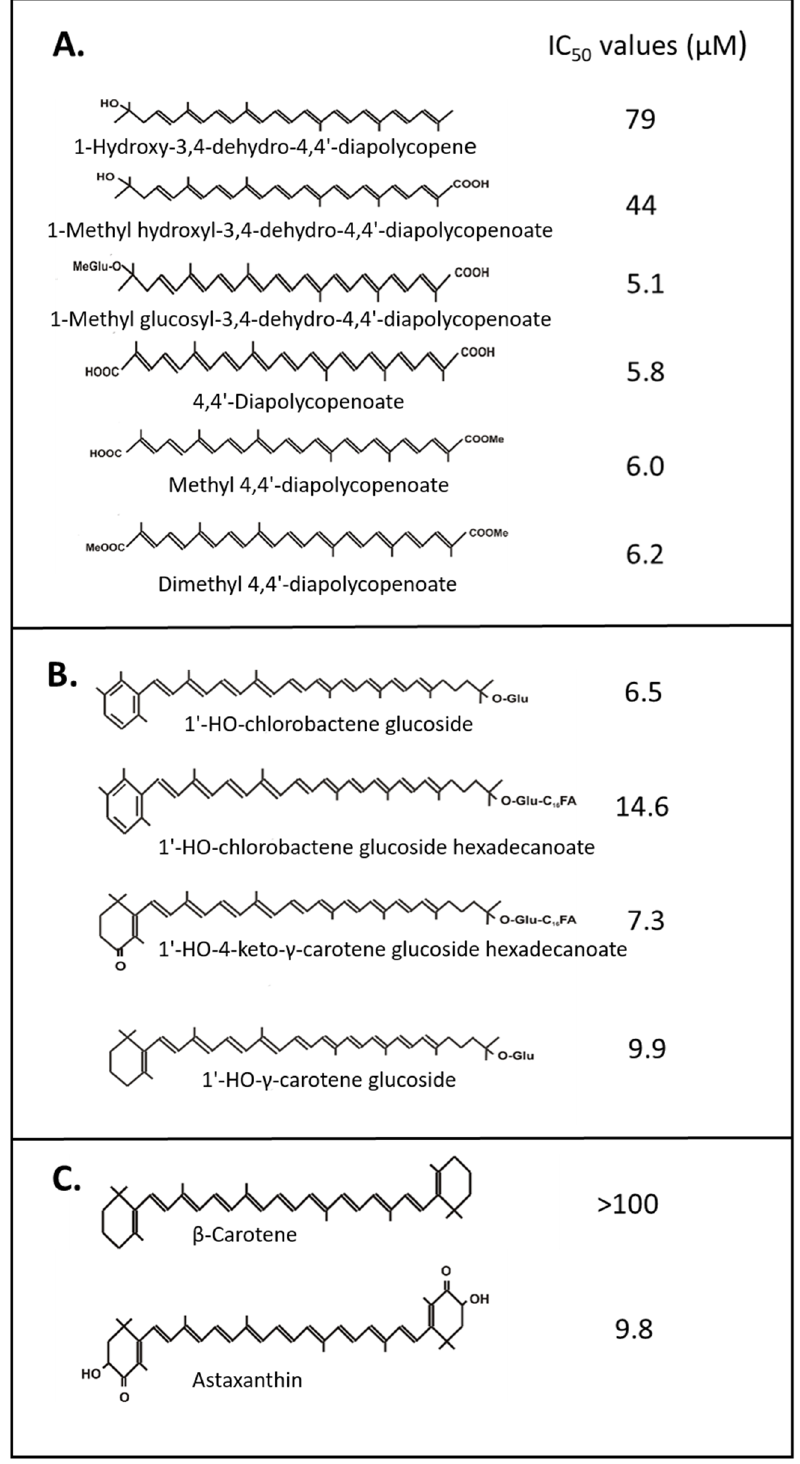
Figure 2. IC 50 values of carotenoids as 1 O 2 quenchers assayed according to [20]. ( A ) C 30 4,4’ ‐ diapolycopene derivatives [20–23], ( B ) monocyclic carotenoids [24], ( C ) astaxanthin and β‐ carotene for comparison